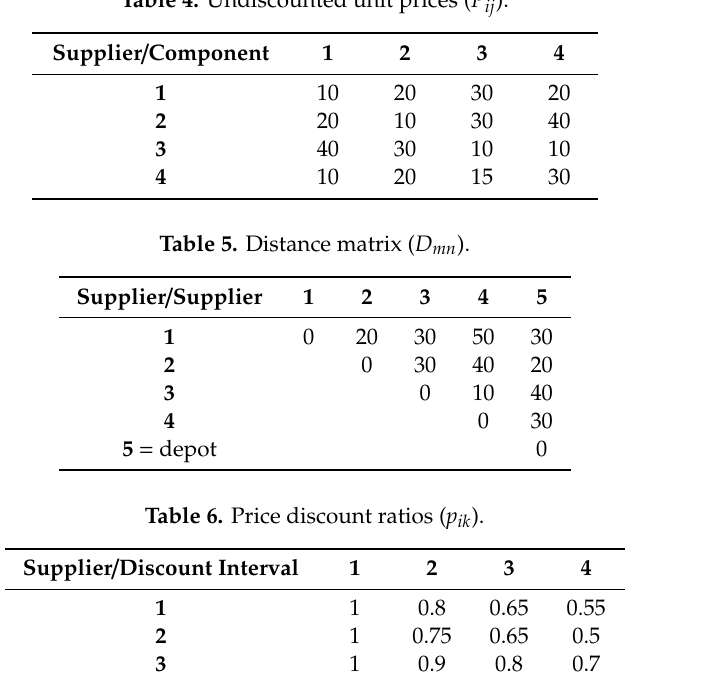
Table 4. Undiscounted unit prices ( P ij ).